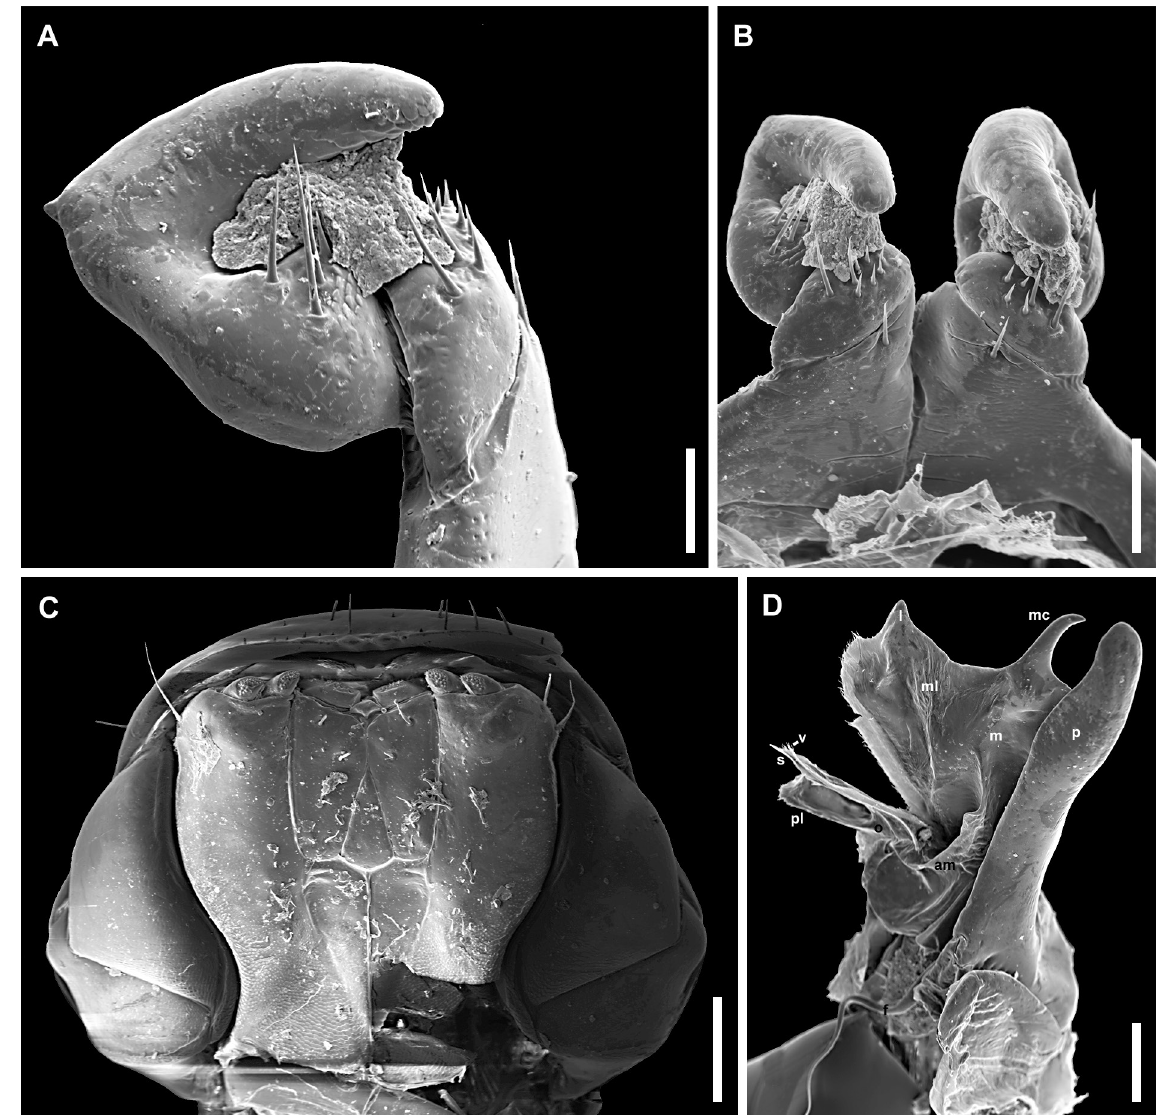
Fig. 26. Leucogeorgia lobata sp. nov., paratype ♂ from Kalitshona Cave (ZMUM). A . Left leg 1, lateral view. B . Leg-pair 1, anterior view. C . Head, ventral view. D . Right gonopods, mesal view. Abbreviations: am = accessory membrane; f = flagellum; l = lobe; m = mesomere; mc = mesomeral claw; ml = mesomeral lamella; o = opisthomere; p = promere; pl = protective lamella; s = solenomere; v = velum. Scale bars: A = 0.05 mm; B, D = 0.1 mm; C = 0.2